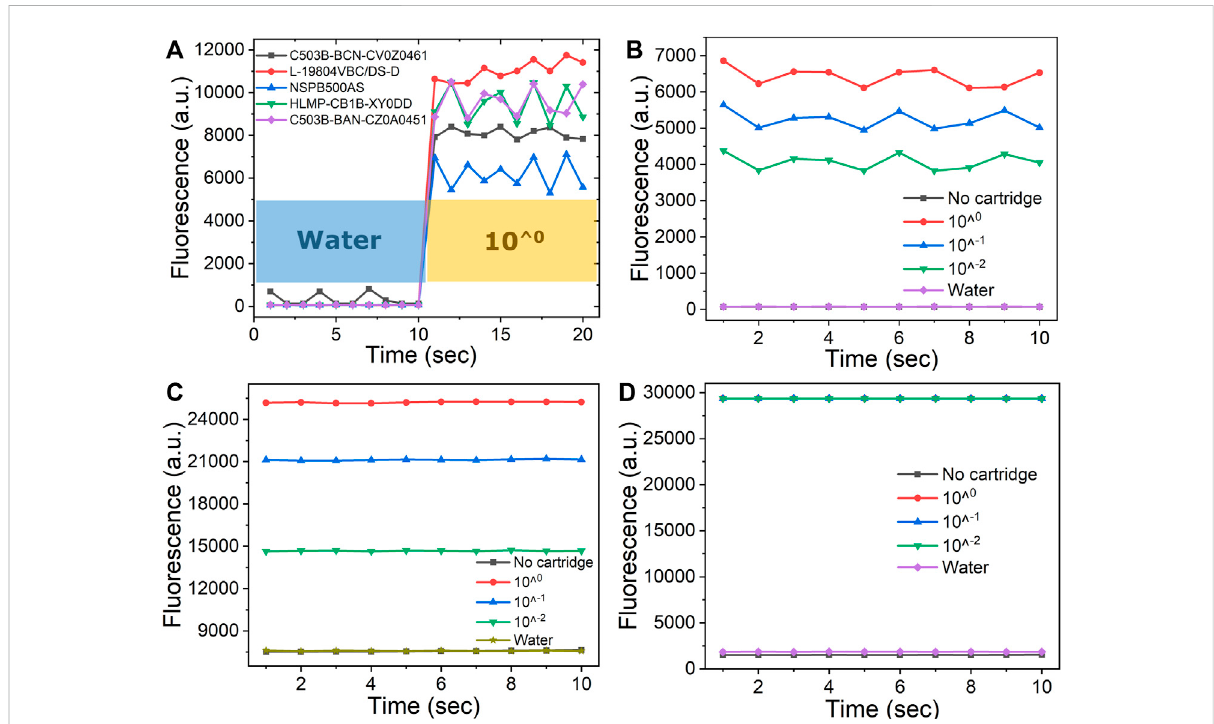
FIGURE 2 Optimization of fl uorescence detection of the fPOC: (A) fi ve different blue LEDs as the light sources were tested with water and 10 times dilutions of rRT- LAMP product; the fl uorescence intensity before (B) and after (C) implement with Operational Ampli fi er tested with water, no cartridge, and a serial dilutions of LAMP product ranging from 10 0 , 10 − 1 , 10 − 2 ; using two different EX/EM fi lter sets of (C) omega and (D) Optolong Optics fi